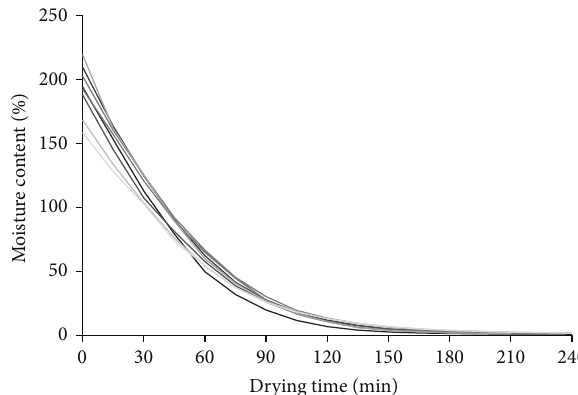
Figure 2: Change in moisture content of eight drying specimens. Moisture content was measured every five minutes and was calcu- lated from weight of oven-dried specimens.